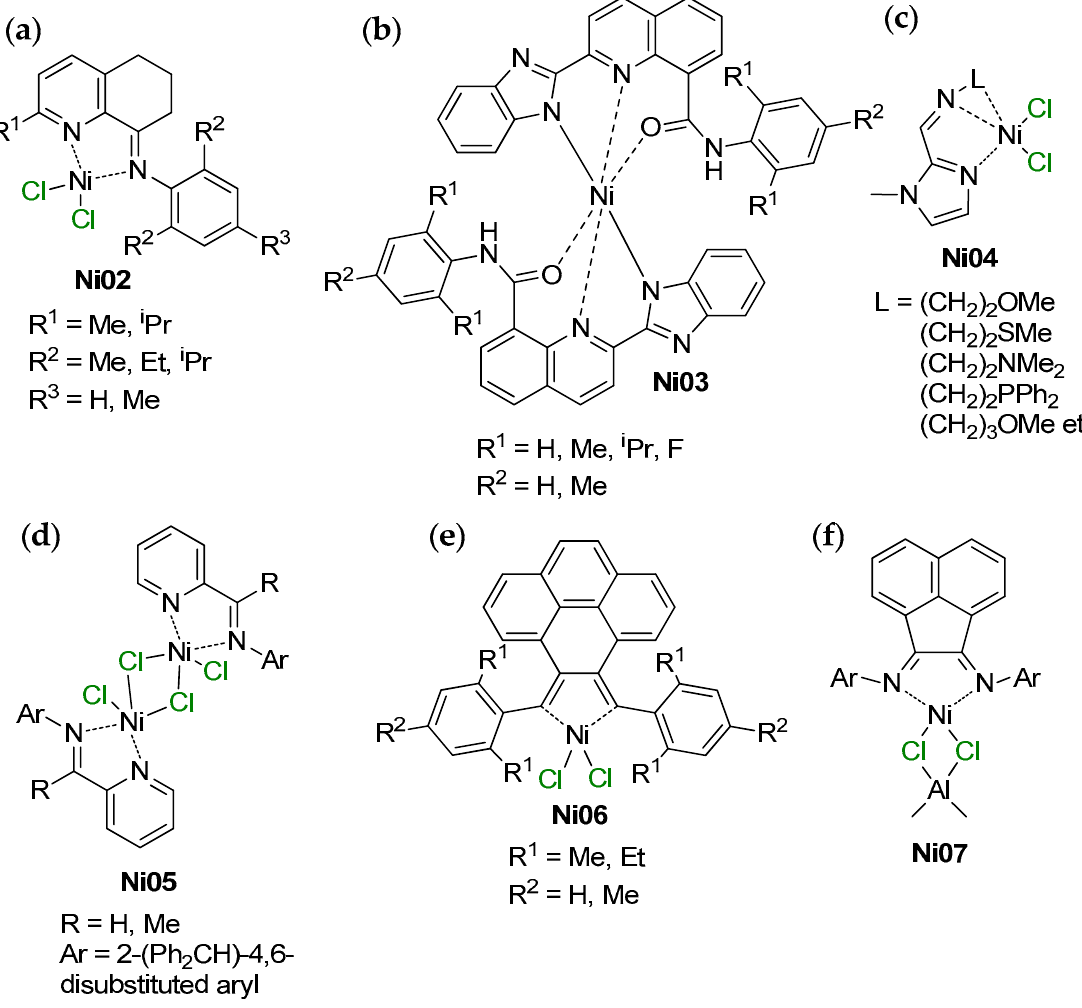
Scheme 40. Structural formula of Ni pre-catalysts studied in α -olefin oligomerization and polymerization: ( a ) Ni02 [272]; ( b ) Ni03 [273]; ( c ) Ni04 [274]; ( d ) Ni05 [275]; ( e ) Ni06 [276]; and ( f ) Ni07